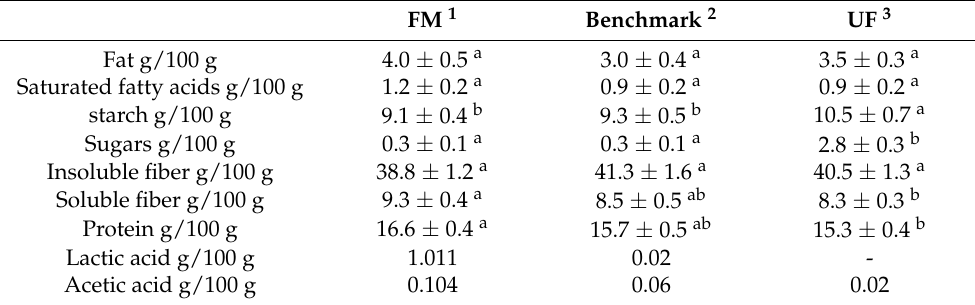
Table 3. Fat, saturated fatty acids, starch, insoluble fiber, soluble fiber, proteins, salt, lactic acid and acetic acid expressed as g/100 g of dry matter (DM), of the preferment FM compared with the benchmark and the UF sample. For the same parameter, average values lacking a common letter ( a,b ) significantly differ from each